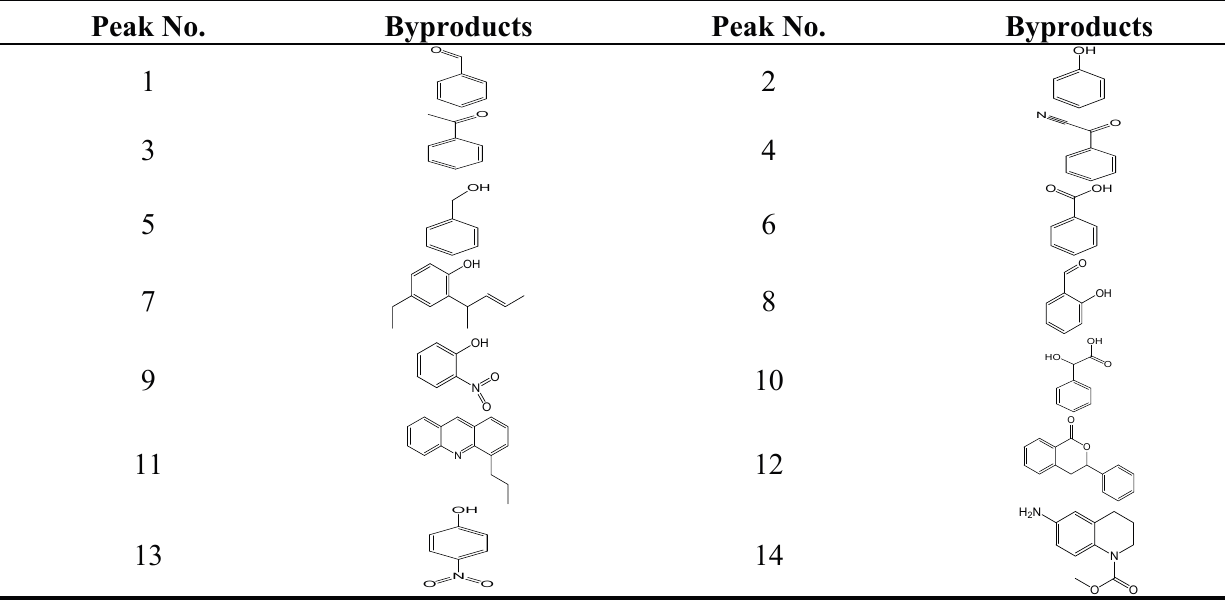
Figure 8. GC-MS chromatogram of intermediate-derivatives. Table 1. Main oil byproducts detected by